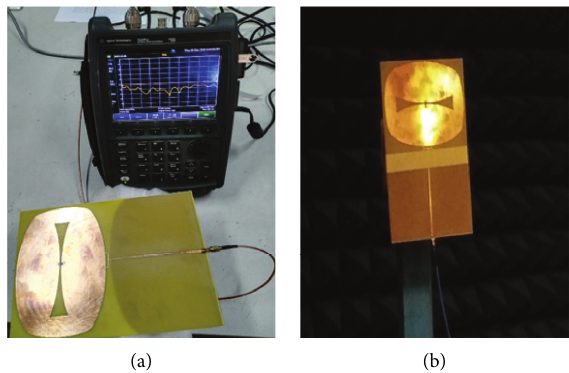
Figure 9: Photographs of the antenna measurement: (a) vector network analyzer (VNA) and (b) anechoic chamber.